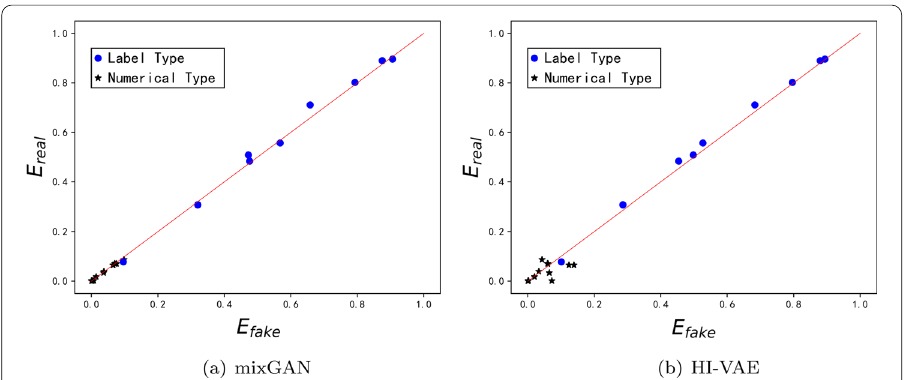
Fig. 4 Generated multi-attribute matching distribution map of data and real